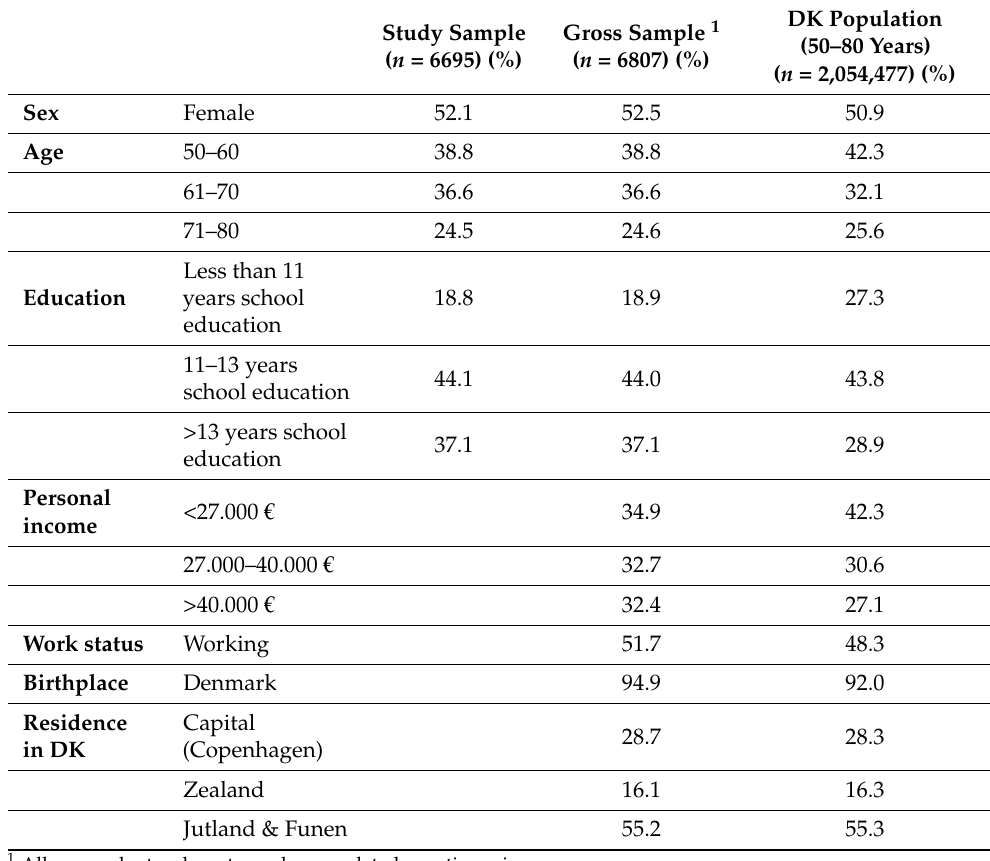
Table 1. Sample characteristics: Study sample and gross sample of 50–80 years old citizens compared to the same-aged Danish